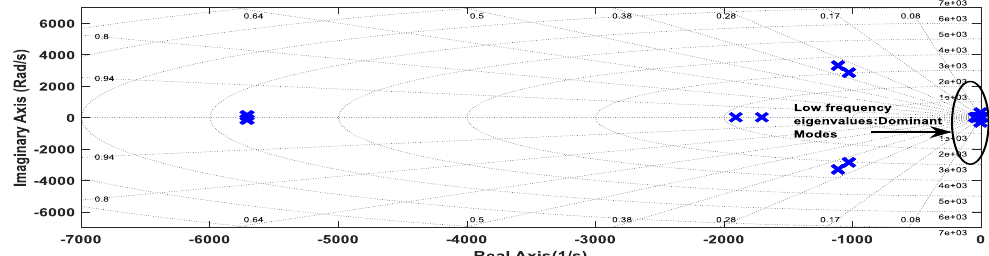
Figure 3. Eigenvalues of system matrix with distributed secondary control (DSC) for stable operation. Participation Factor : The participation factor was employed to find the relationship quantity in the right and left eigenvectors of the state matrix [14]. For the primary droop